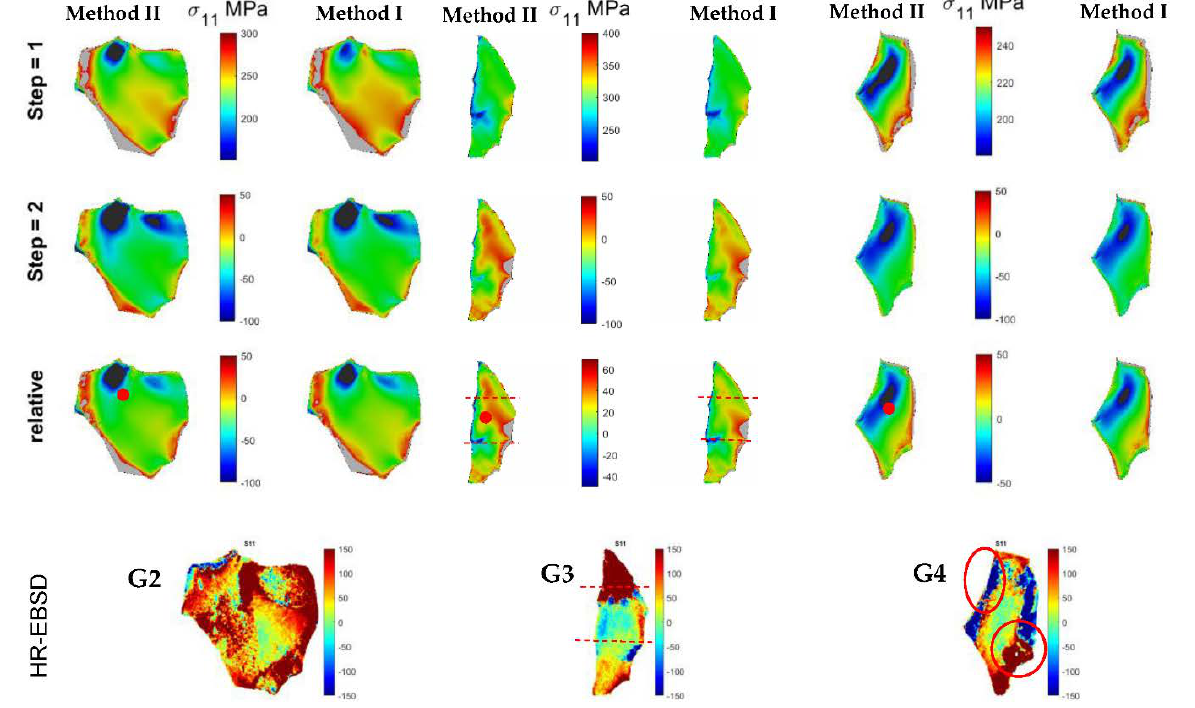
Figure 7. The normal stress component along the loading direction for grain G2, G3, and G4. A comparison between Method I ( right column ) and Method II ( left column ) of the CPFE model and HR-EBSD ( last row ).